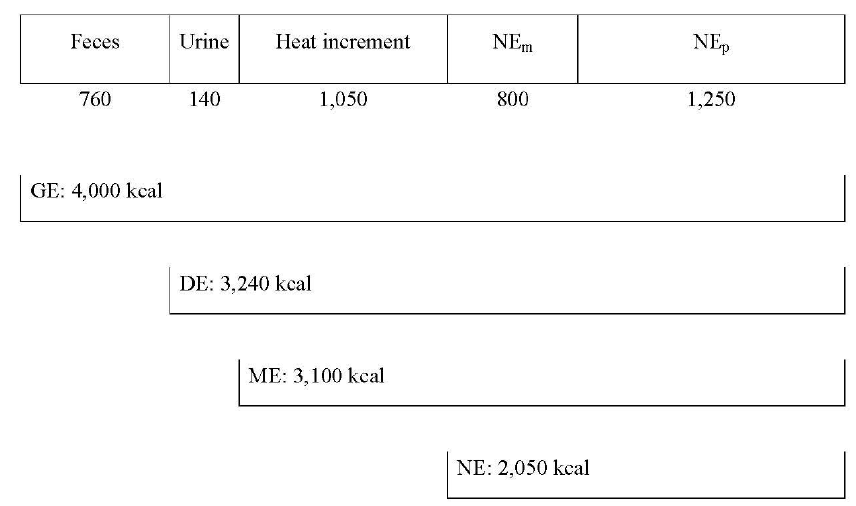
Figure 2. An example of approximate energy utilization of growing pigs fed a corn-soybean meal-based feeds (Kil, 2008). NE p = Net energy for